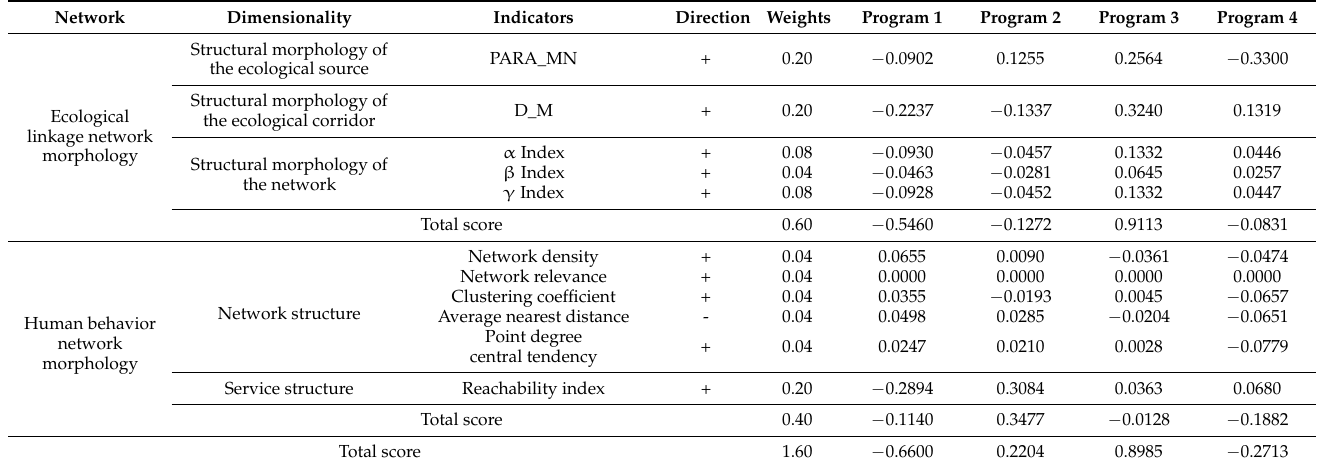
Figure 9. Structure of the human system behavior association network for the alternative planning programs in Zepan Village. Table 3. Evaluation results of the spatial morphology of each alternative planning program in Zepan